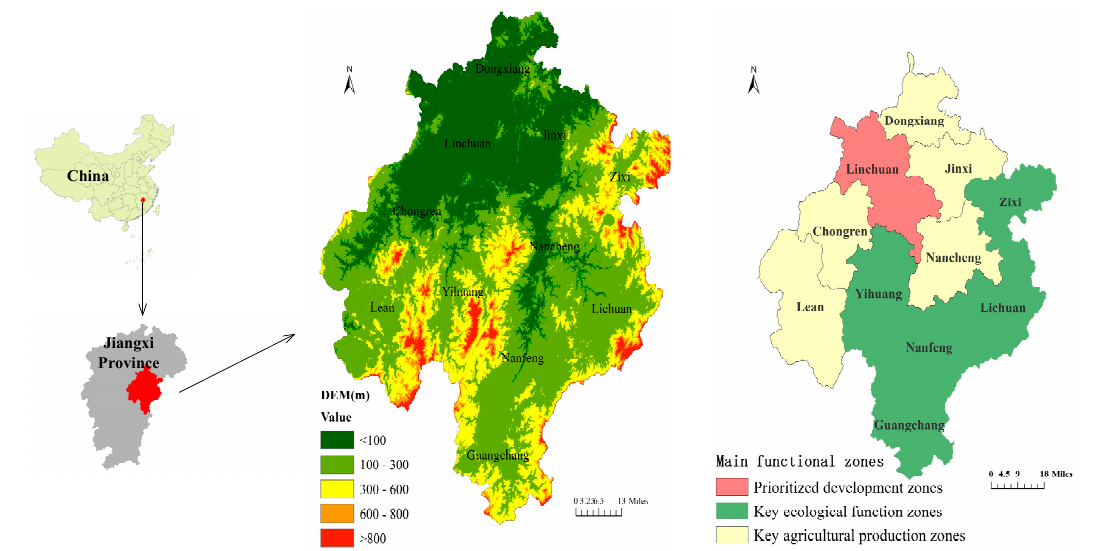
Figure 1. The research area of Fuzhou City located in the eastern part of Jiangxi Province covers a total area of 18,800 square kilometers. The main functional zones are classified as prioritized development zones (Linchuan); key agricultural production zones (Dongxiang, Jinxi, Nancheng, Chongren, and Le’an); and key ecological function zones (Yihuang, Nanfeng, Guangchang, Lichuan, and Zixi).